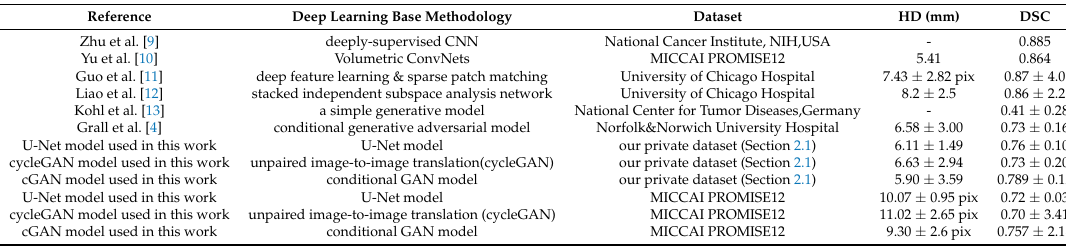
Table 2. The state-of-the-art prostate segmentation approaches for the MRI-T2W modality. The HD is reported in ‘mm’ except for the datasets that contain data from multiple centres. In this case, the HD is reported in pixels (shown as